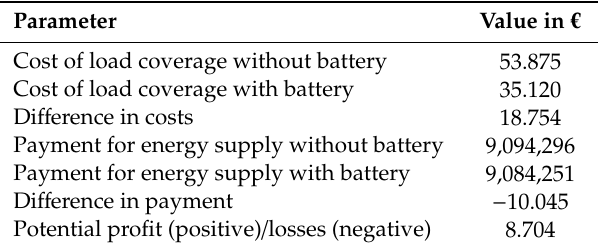
Figure 12. Battery storage system operation using energy market information (2 March 2016).